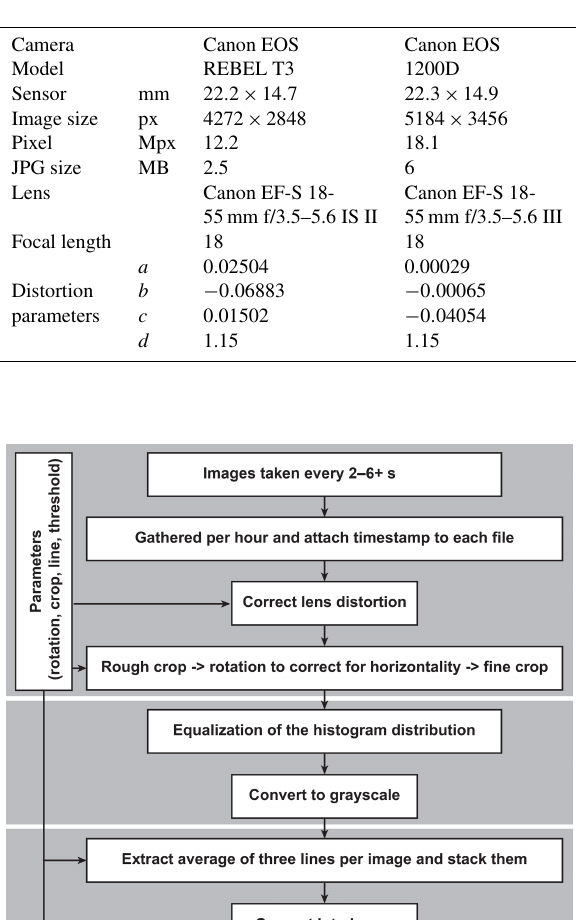
Table A1. Camera details and lens distortion parameters.